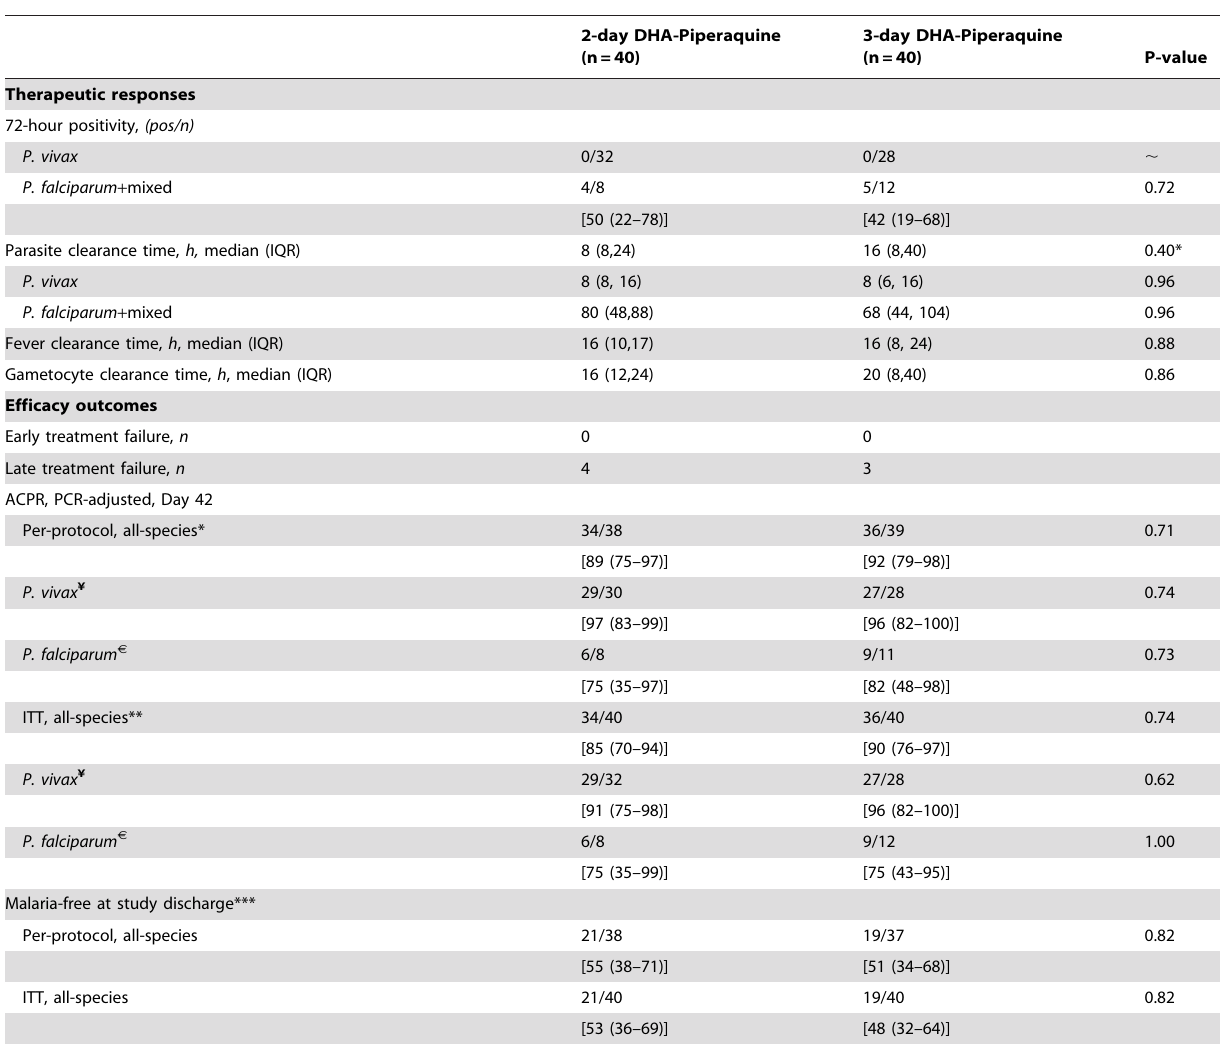
Table 2. Therapeutic responses and PCR-corrected outcomes by treatment